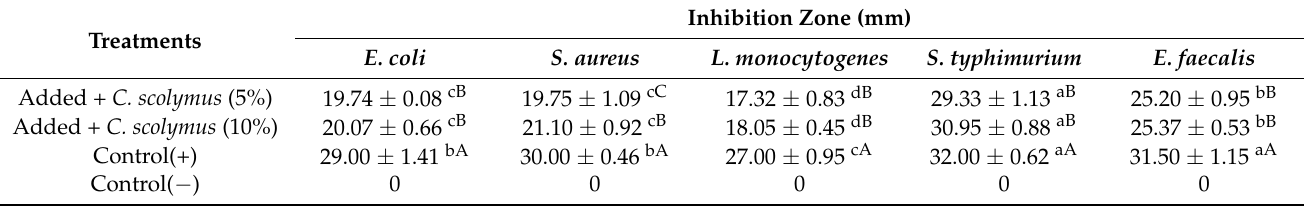
Values are expressed as means ± SD. Standard disk; 6mm, control(+); ampicillin, control( − ); distilled water, a,b,c,d : Means followed by different letters within the same line represent significant differences ( p < 0.05). A,B,C : Means followed by different letters within the same column represent significant differences. Data are the average of